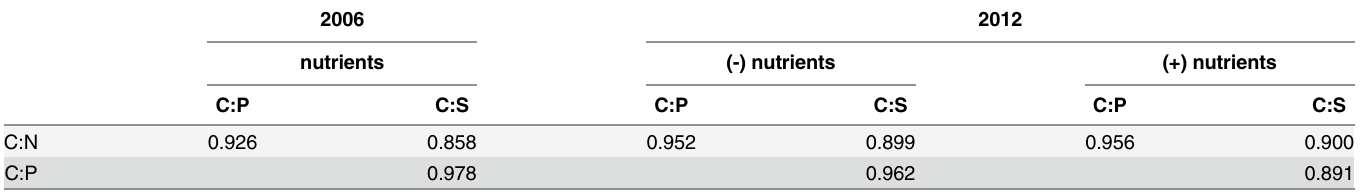
Table 5. Correlation between the changing FF-C:N, -C:P and -C:S ratios with depth (0 to 1.6 m) in 2006 and for the ( − ) and (+) nutrient treatments in 2012, n = 16